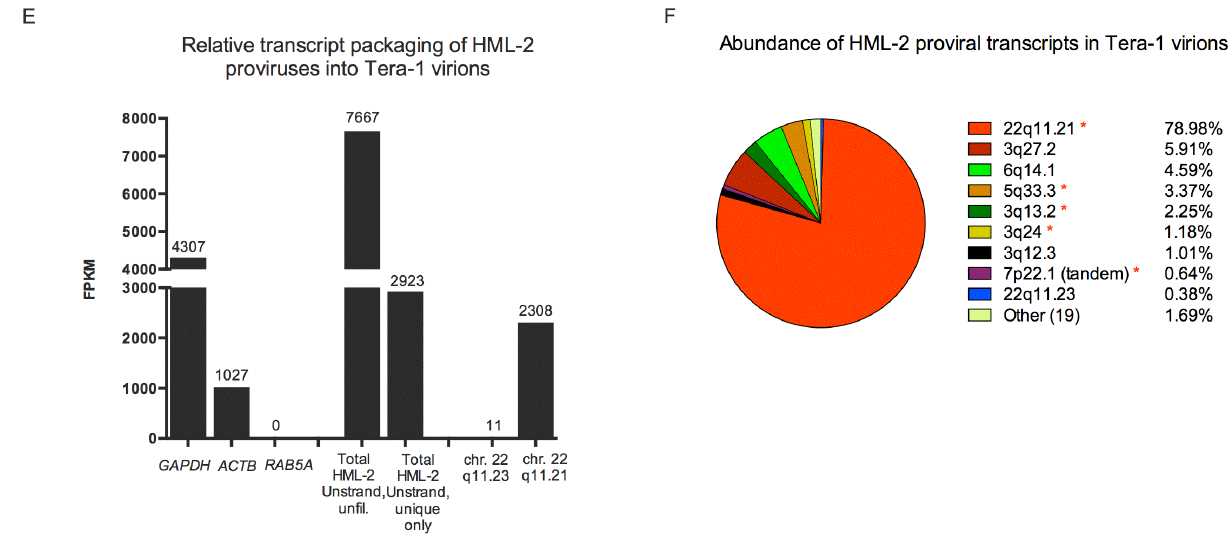
Figure 2. HML-2 expression in Tera-1 cells and virions. ( A , B ) RNASeq reads originating from Tera-1 cells were aligned to the hg19 build of the human genome and analyzed using the Plus stranded, Unique Only analysis, except as indicated. ( E – F ) RNASeq reads originating from Tera-1 virions were aligned to the hg19 build of the human genome and